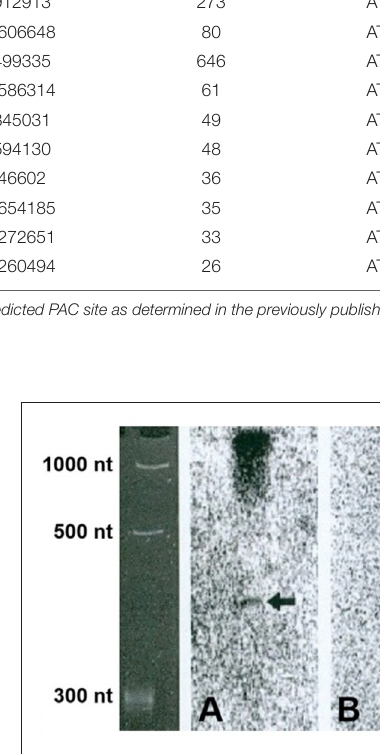
FIGURE 3 | 5 ′ -UTR transcripts verified by northern blot. Arrows point to the truncated transcripts. (A) Gene no. 5, AT5G20450, (B) gene no. 7, AT1G13190, (C) gene no. 9,